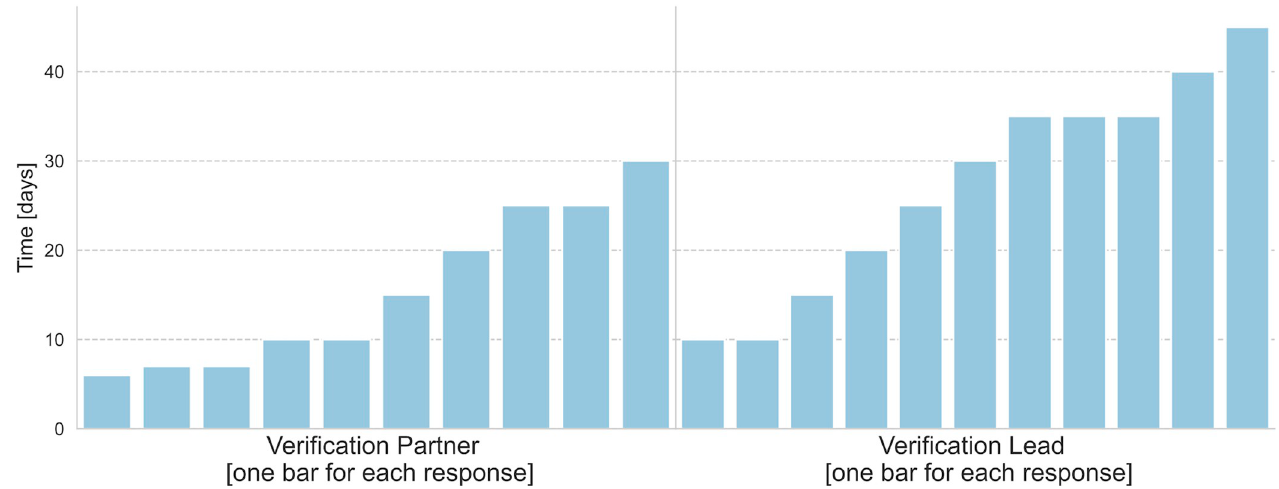
Fig 4. Responses of the verification sample (see chapter 2.2.3) to the question “what total number of days they and their organization in total spent preparing proposals”. Each bar represents one response.